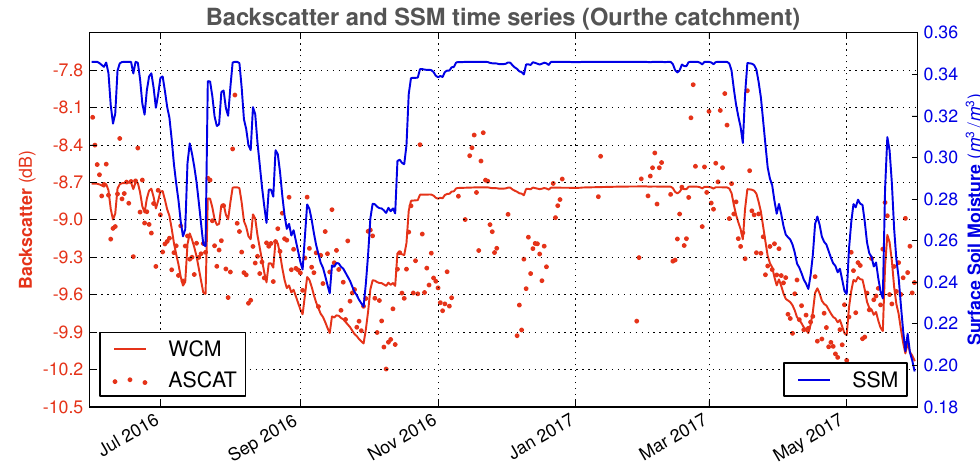
Figure 13. Spatially averaged backscatter, simulated (WCM) and observed (ASCAT) and SSM (deterministic SCHEME run) for the Ourthe catchment, June 2016–May 2017.